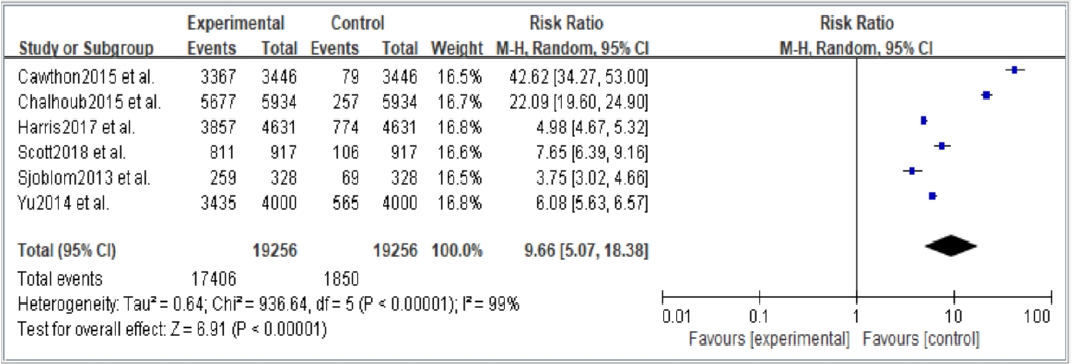
Figure 3. Summary estimates for the sarcopenia status compared to fracture outcome.